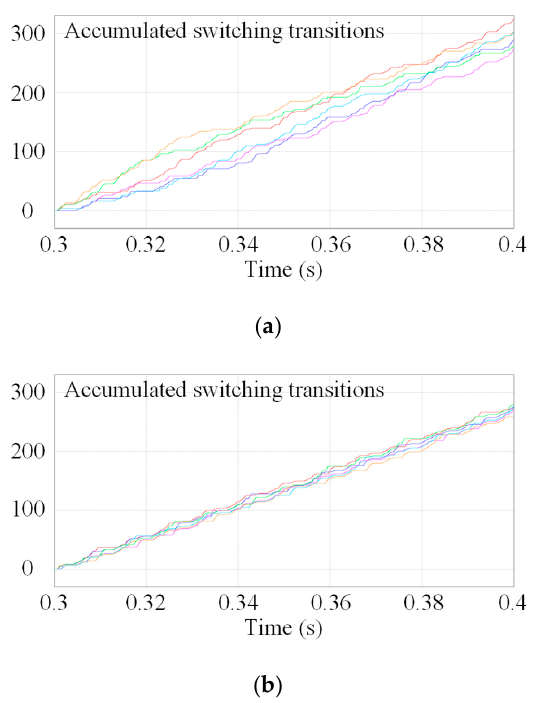
Figure 8. The number of accumulated switching transitions within 0.1 second among six SMs: ( a ) without switching loss balancing control; ( b ) with switching loss balancing control.